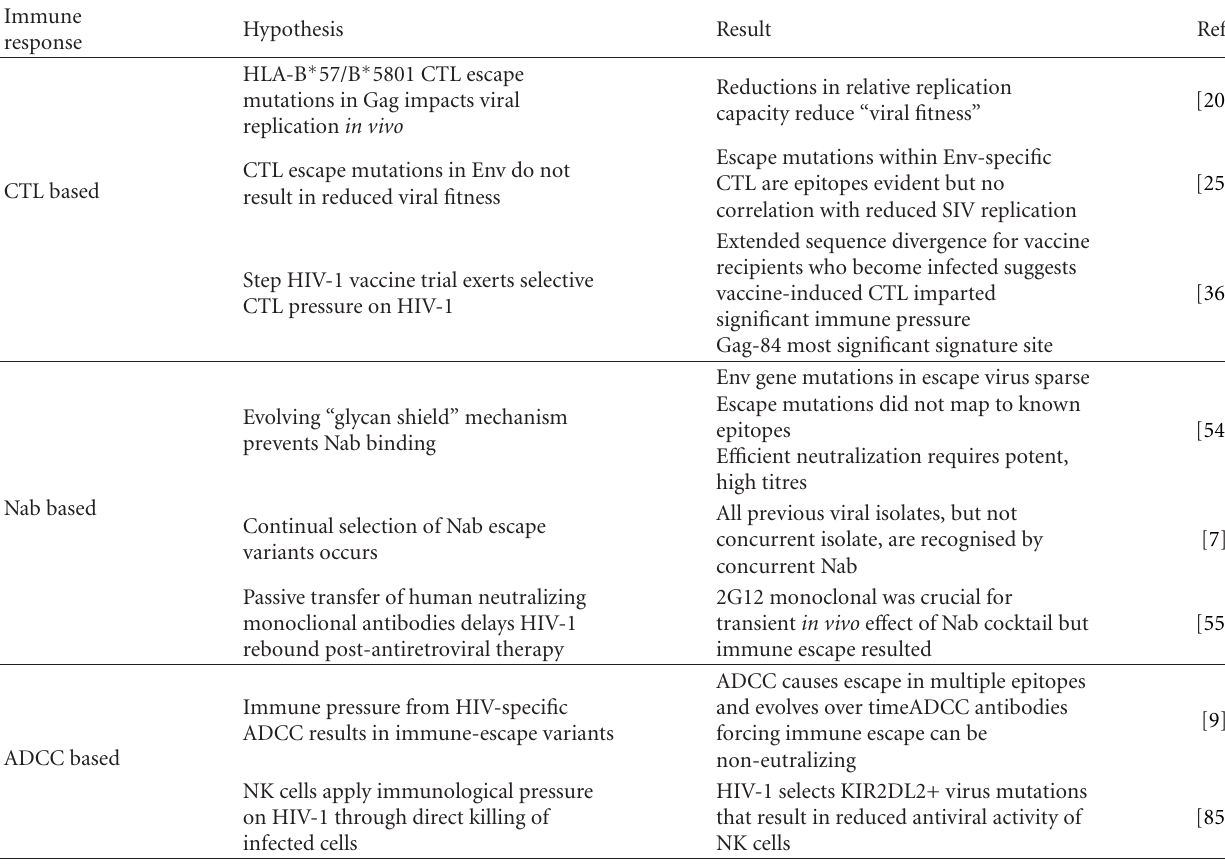
Table 1: Key escape